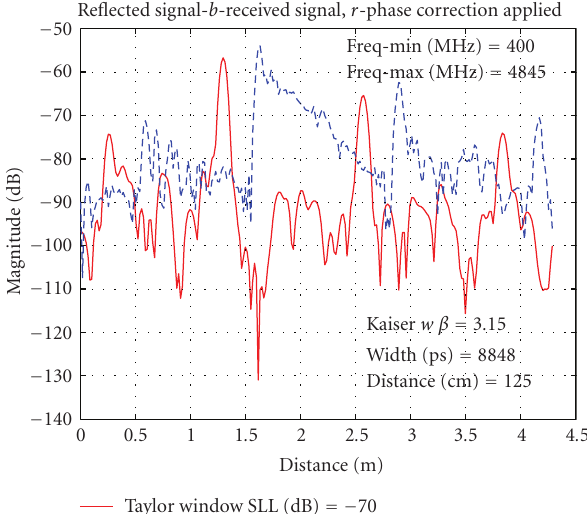
Figure 10: A range profile before calibration (blue line) and after calibration (red line) for a distance of 127 cm; data measured with